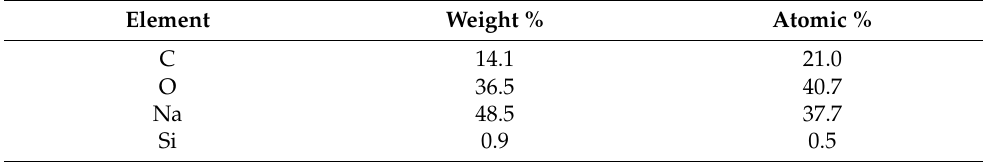
Table 11. The chemical components detected on the surface of LWA in geopolymer matrix.